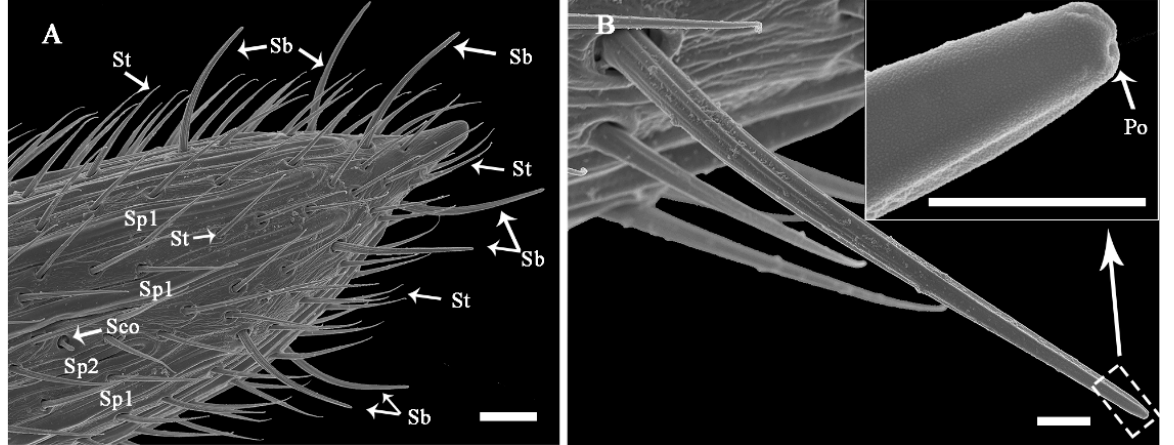
Figure 7. Fine morphology and distribution of antennal sensilla on the tip of the flagella of Coeloides qinlingensis . ( A ) Lateral view of the last flagellomere. ( B ) Characteristic ribbed peg stemming from a flexible socket at the flagellar tip. The inset shows a few pores at the end of the peg. Sb, sensilla basiconica; Sp1-2, sensilla placodea 1 and 2; Sco, sensilla coeloconica, Po, Pore. The same acronyms and abbreviations are used in subsequent figures. Scale bar: A = 10 μ m; B = 2 μ m, inset = 200 nm.